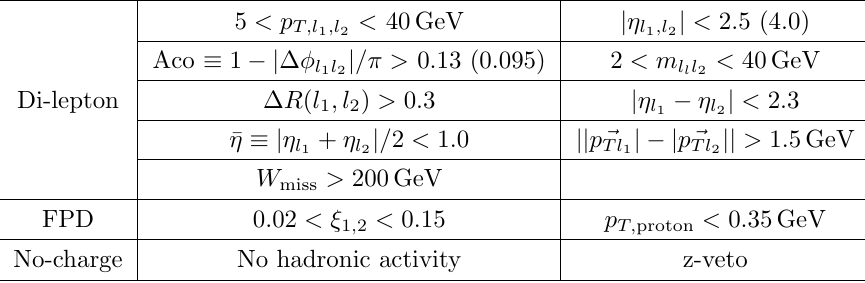
Table 2 . Cuts used in this analysis.